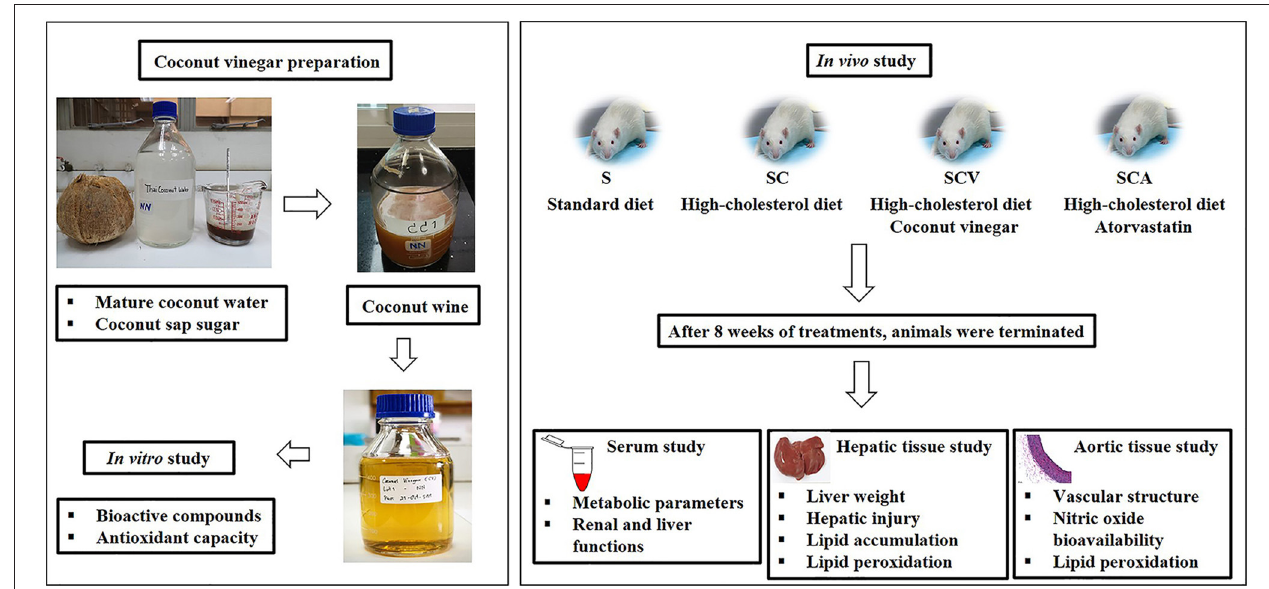
FIGURE 1 | Study protocol.